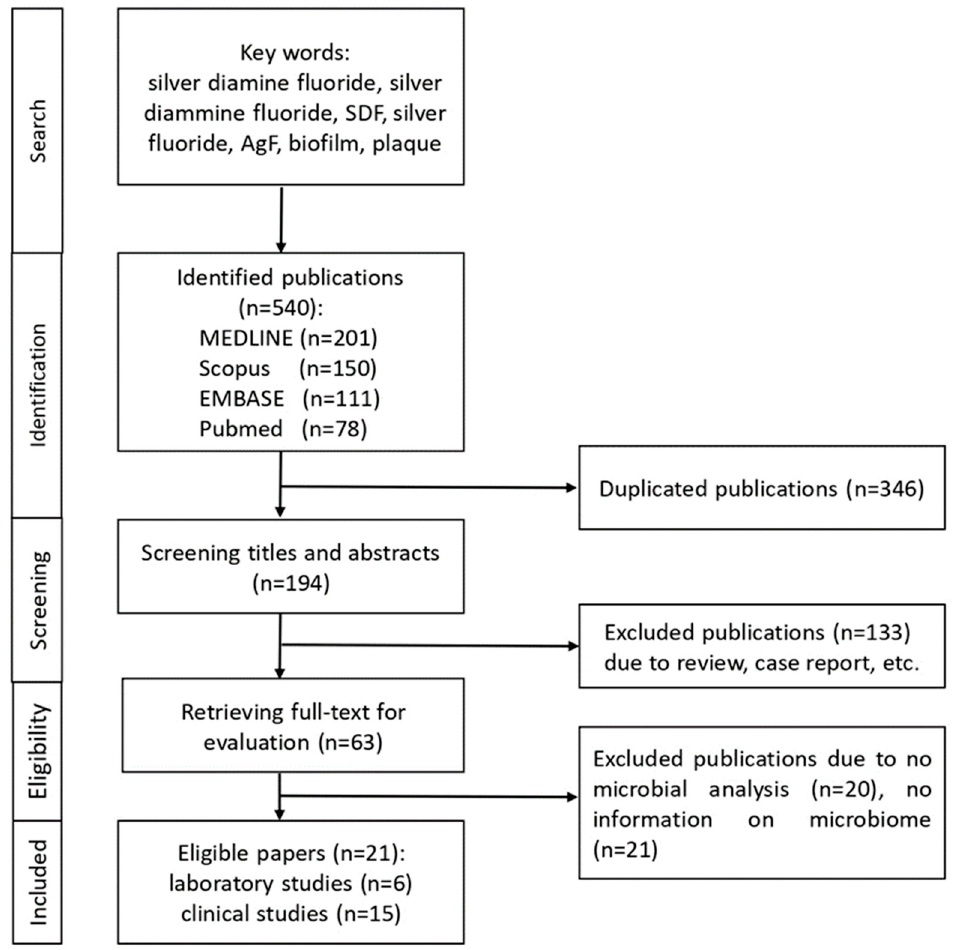
Figure 1. Flowchart of the study selection process: identification, selection, eligibility, included.